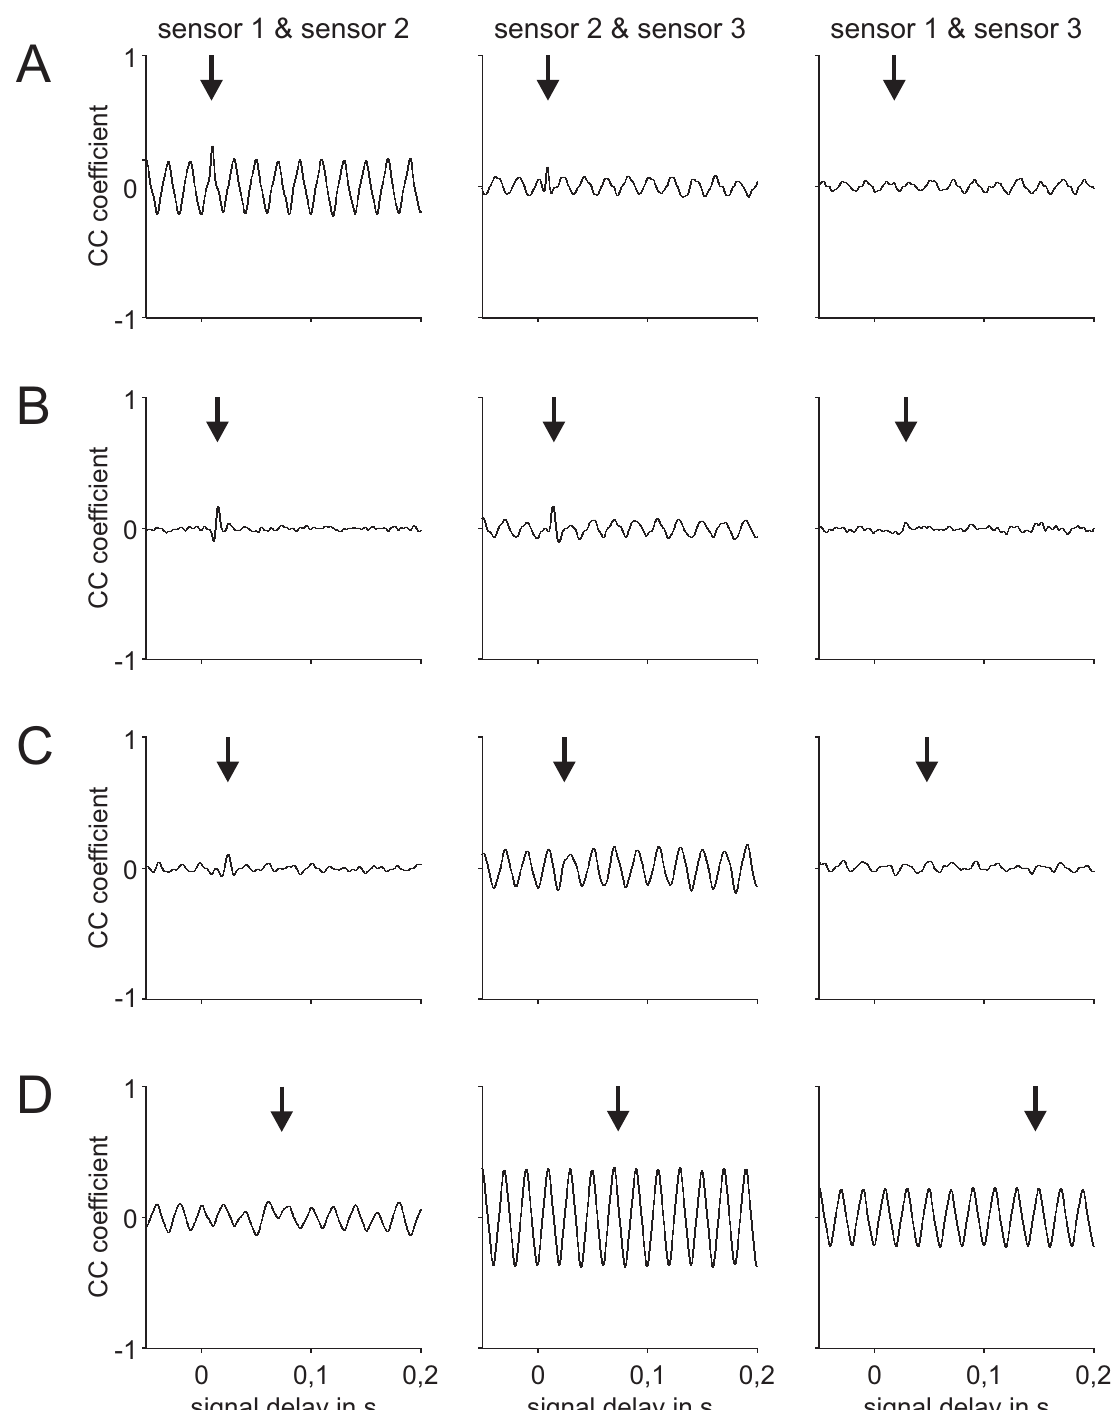
Figure 8. Cross-correlation (CC) functions of the output signals of the micro-machined sensors in the tap water application. Cross-correlations, each based on two of the micro-machined sensors and a 10 s time interval for the reference velocities of 4066 L/h ( A ), 2550 L/h ( B ), 1536 L/h ( C ), and 500 L/h ( D ). Arrows indicate temporal offset expected from the reference flow rate